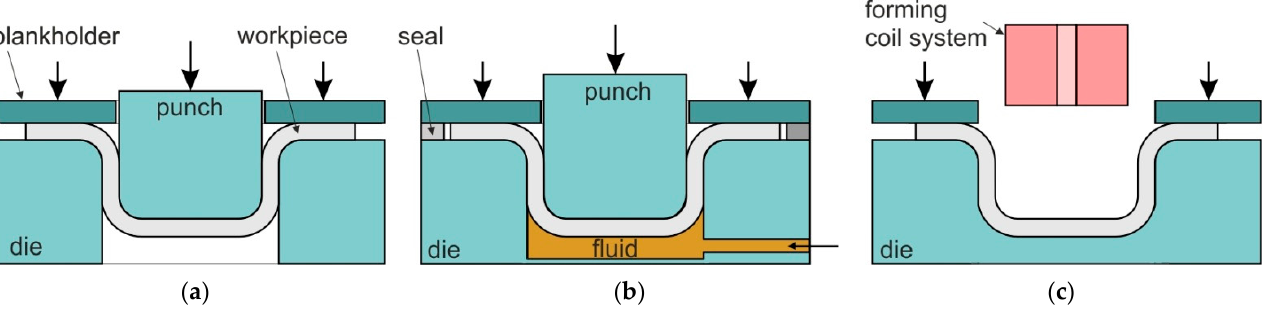
Figure 31. Variants of die forming methods: ( a ) stamping, ( b ) hydroforming, and ( c ) electromagnetic forming.